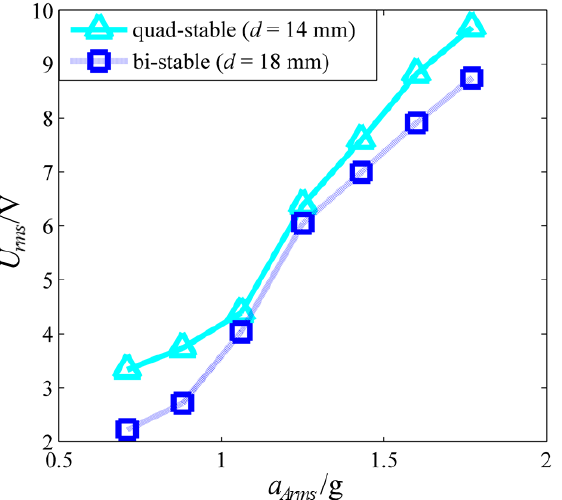
Figure 3. Estimated U rms − a Arms curves when a Arms falls within the range of 0.71 – 1.77 g. Figure 4 shows the output displacement, open circuit voltages, phase portraits, and power spectrum densities (PSDs) of the voltages under the quad-stable and bi-stable structural parameters when a Arms = 0.88 g. As shown in Figure 4(a1 – d2), when a Arms = 0.88 g, the harvester achieves one-sided bi-stable inter-well movement under the quad-stable structural parameters, while it only vibrates in a single potential well under the bi-stable structural parameters; the U rms values under the quad-stable and bi-stable structural pa- rameters are 3.74 and 2.71 V, respectively; the ranges of the output displacement under the quad-stable and bi-stable structural parameters are − 28.2 –− 1.6 and − 23.6 –− 0.3 mm, re- spectively; the amplitude of the PSD of the voltage under the quad-stable structural pa- rameters is greater than that under the bi-stable structural parameters within the fre- quency range of 0 – 3 Hz.